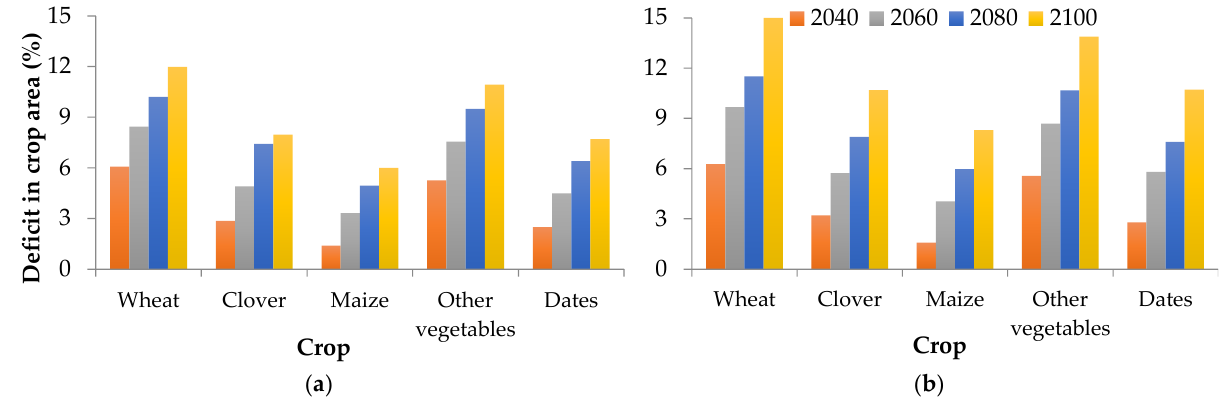
Figure 13. Deficit in crop areas (%) in Al Quassim region for 2040, 2060, 2080, and 2100: ( a ) SSP2-4.5 and ( b ) SSP5-8.5.